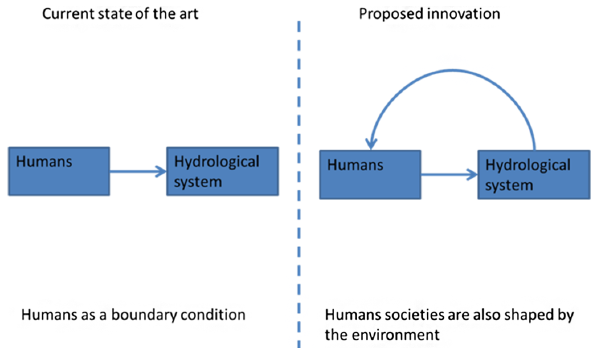
Fig. 1. An illustration of feedbacks between hydrological systems and human